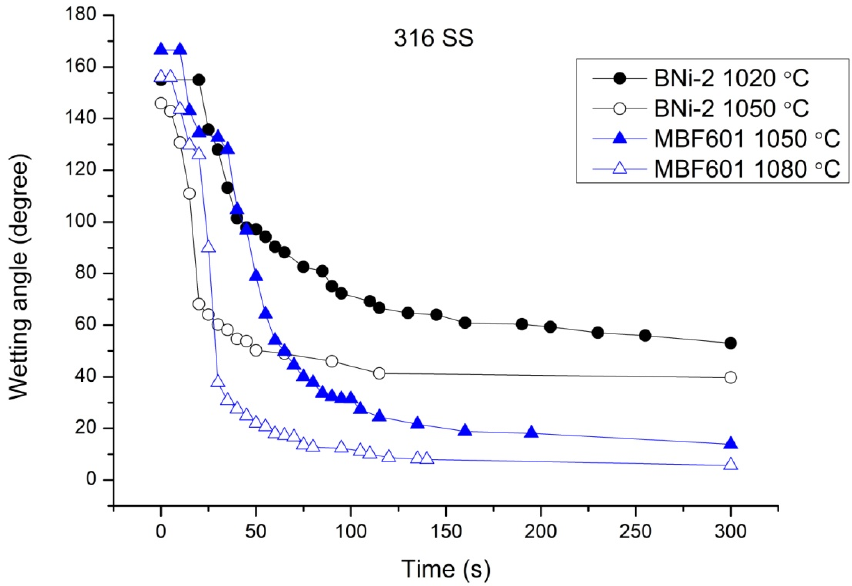
Figure 2. The dynamic wetting angles of BNi-2 and MBF601 fillers on the 316 SS.